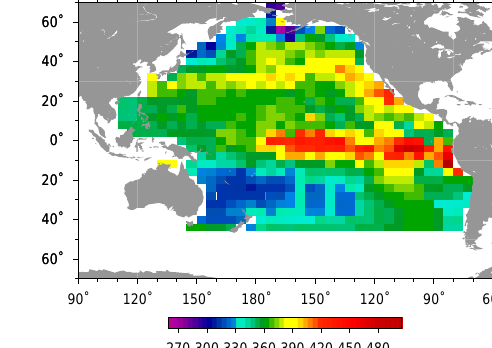
By contrast, surface water in the eastern tropical Pacific cold tongue region tends to be highly supersaturated with re- spect to atmospheric CO 2 . This is associated with the wind- driven equatorial divergence and turbulent mixing that brings colder, saline and nutrient- and CO 2 -rich subsurface waters to the surface. The cold tongue is characterized by lower